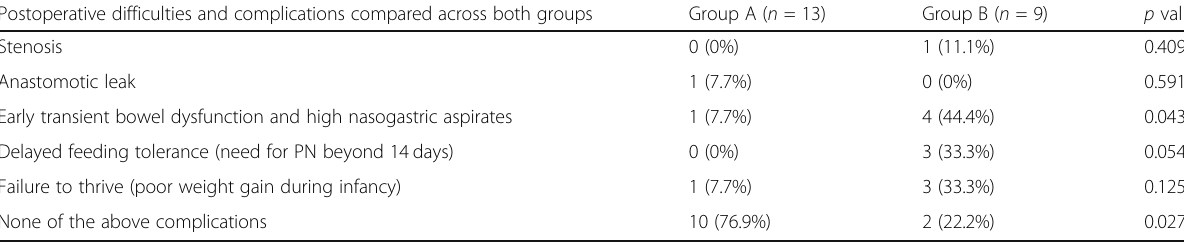
Table 2 Postoperative difficulties and complications across both groups Postoperative difficulties and complications compared across both groups Group A ( n = 13)